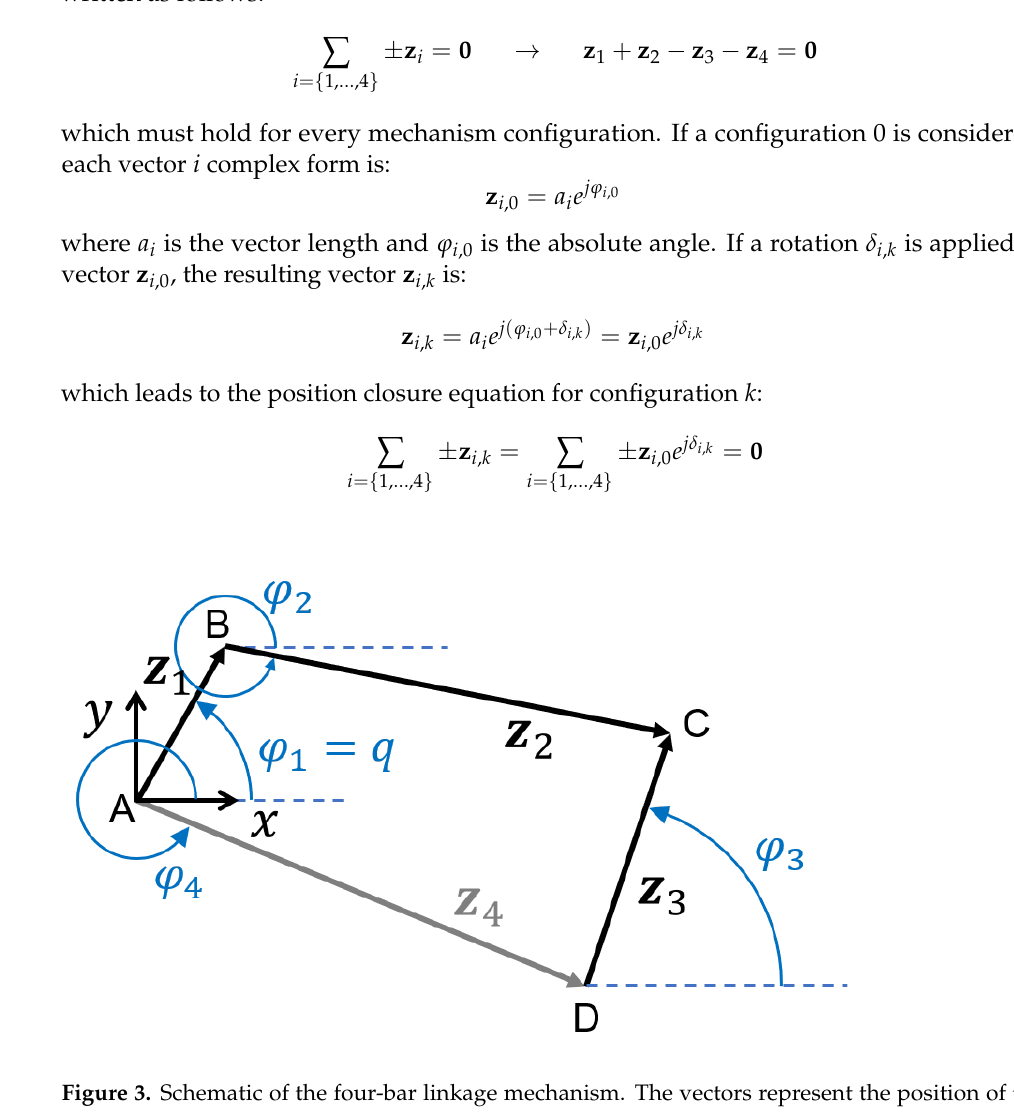
Figure 3. Schematic of the four-bar linkage mechanism. The vectors represent the position of the links of the